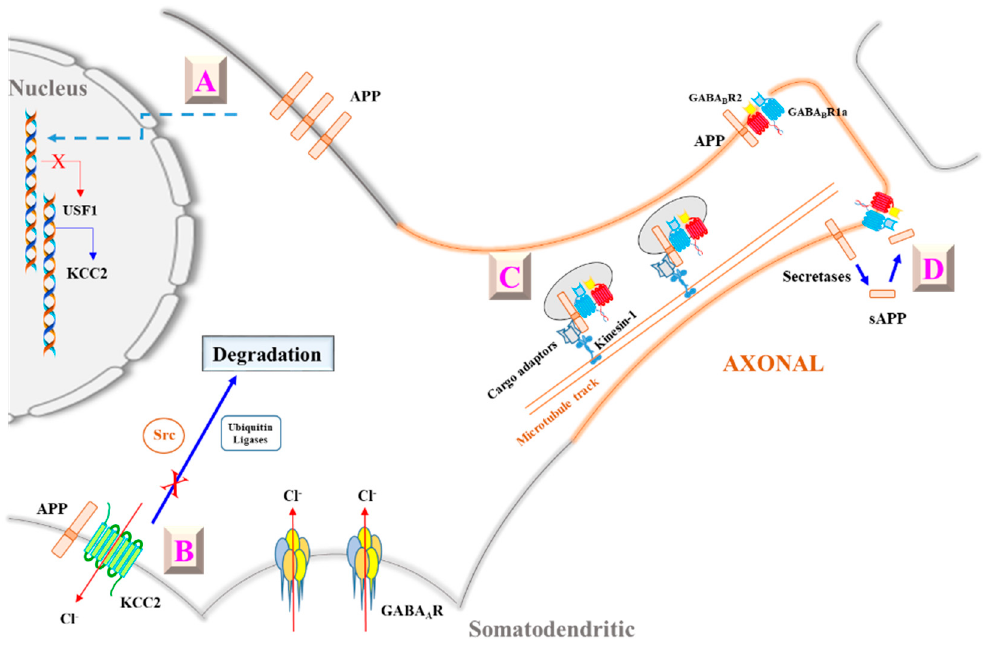
Figure 1. A schematic diagram illustrating amyloid precursor protein’s (APP’s) modulation of γ -aminobutyric acid (GABA)ergic neurotransmission via its interaction with potassium chloride cotransporter 2 (KCC2) and GABA B receptor 1a (GABA B R1a). A: APP modulates KCC2 expression by suppressing the levels of a KCC2 transcription factor UCF-1 in an unknown manner [65]. B: APP can also interact directly with KCC2, and maintains its levels and stability by inhibiting tyrosine phosphorylation and ubiquitination-based degradation [64]. APP’s modulation of KCC2 levels alters intracellular Cl − and shifts E GABA , thereby a ff ecting inhibitory signaling through GABA A Rs. C: APP’s interaction with GABA B R1a’s sushi domain allows it to e ff ectively aid axon targeting of GABA B R1a-GABA B R2 dimers [66]. D: Furthermore, secreted (s)APP generated by secretase cleavage could bind as a ligand to GABA B R1a to modulate GABA B R’s presynaptic roles [67]. See text for more details.